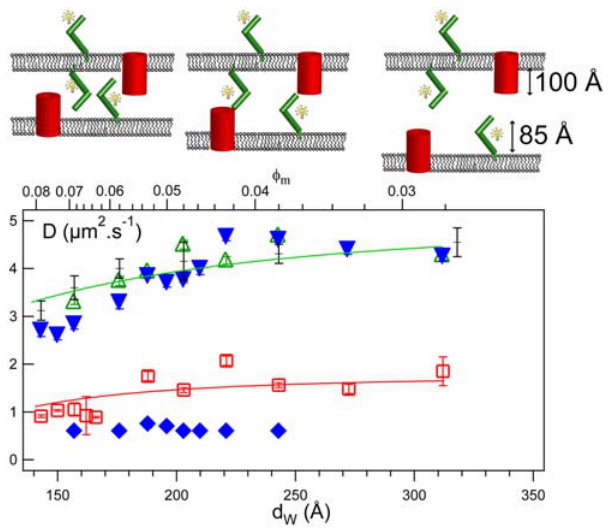
Figure 4. Interaction between MexA and OprM: Evolution of the diffusion coefficient of the proteins with the distance between bilayers. The top sketch represents OprM trimer (barrel) and MexA (sticks) protein diffusing in the bilayers. The bottom plot represents the variation of diffusion coefficients vs bilayer distance d W : for FITC-labeled MexA (green triangles up),FITC-C 16 (a SOPC lipid) (black crosses) and OprM (red empty squares) in the sponge phase devoid of OprM and MexA, respectively, for free (blue triangles down) and bound (blue diamonds) MexA inserted in a sponge phase containing OprM trimers. The results are compared with the expected w m 2 variation law (equation 1) for MexA (green solid line) and for OprM(red solid line). The only change compared with the peptide variation is the value of the asymptotic diffusion coefficient. Error bars are smaller than symbol size.The corresponding volume fraction w m is indicated at the top of the graph.